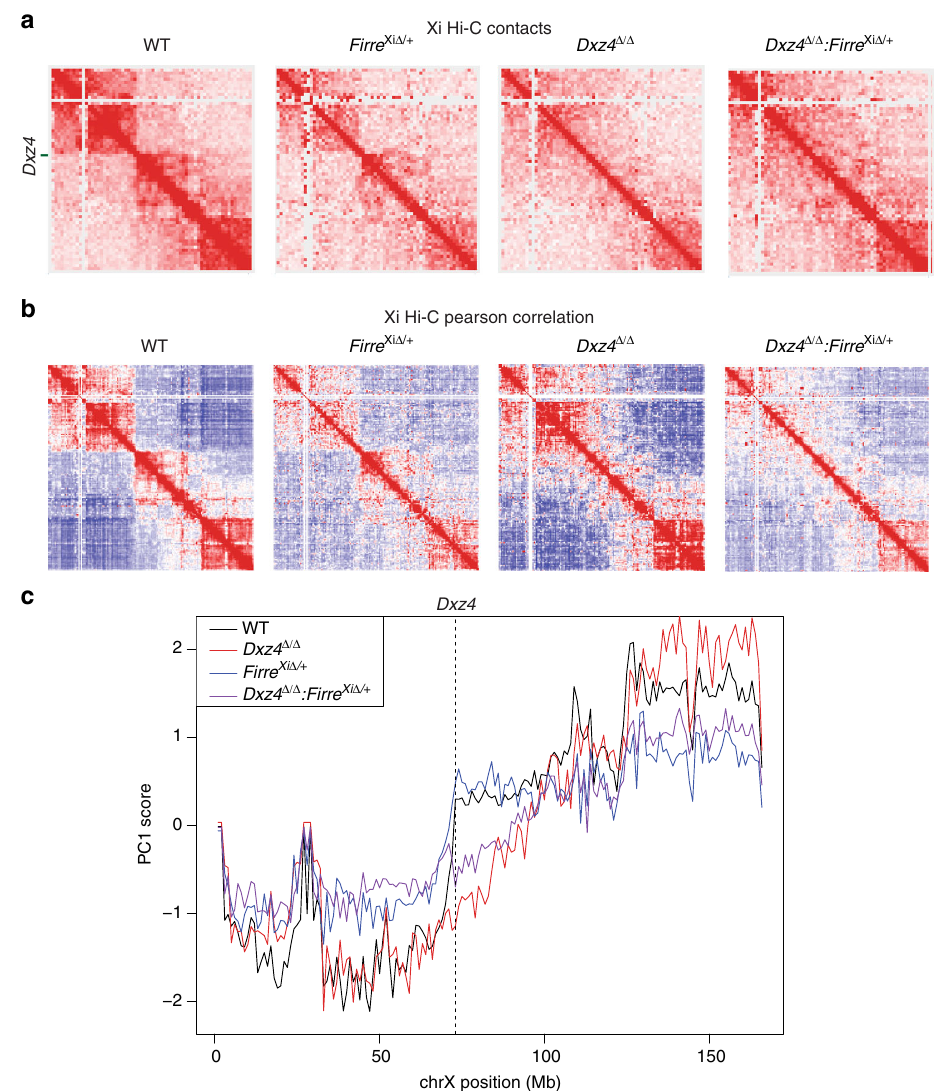
Fig. 6 The effects of deleting Firre on megadomains. a Contact maps for the Xi at 2.5 Mb resolution for wild-type (left), Firre Xi Δ / + (center left), Dxz4 Δ / Δ (center right; duplicated from Fig. 3) and Dxz4 Δ / Δ : Firre Xi Δ / + (right) cells on d10 of differentiation. b Pearson correlation matrices at 1 Mb resolution for wild-type (left), Firre Xi Δ / + (center left), Dxz4 Δ / Δ (center right; duplicated from Fig. 3) and Dxz4 Δ / Δ : Firre Xi Δ / + (right). c 1st principal component of the 1 Mb correlation matrix plotted for wild-type (black), Dxz4 Δ / Δ (red; duplicated from Fig. 3), Firre Xi Δ / + (blue) and Dxz4 Δ / Δ : Firre Xi Δ / + (purple) across all bins on the Xi. The dotted line corresponds to the bin containing Dxz4 . All data in this fi gure are generated from merging together reads from two biological replicates. Note: The Dxz4 Δ / Δ contact maps and correlation maps in a and b are the same as in Fig. 3b, and the Dxz4 Δ / Δ PC1 curve in c is the same as in Fig. 3c. The Dxz4 Δ / Δ data is included again in this fi gure to enable comparison across all four